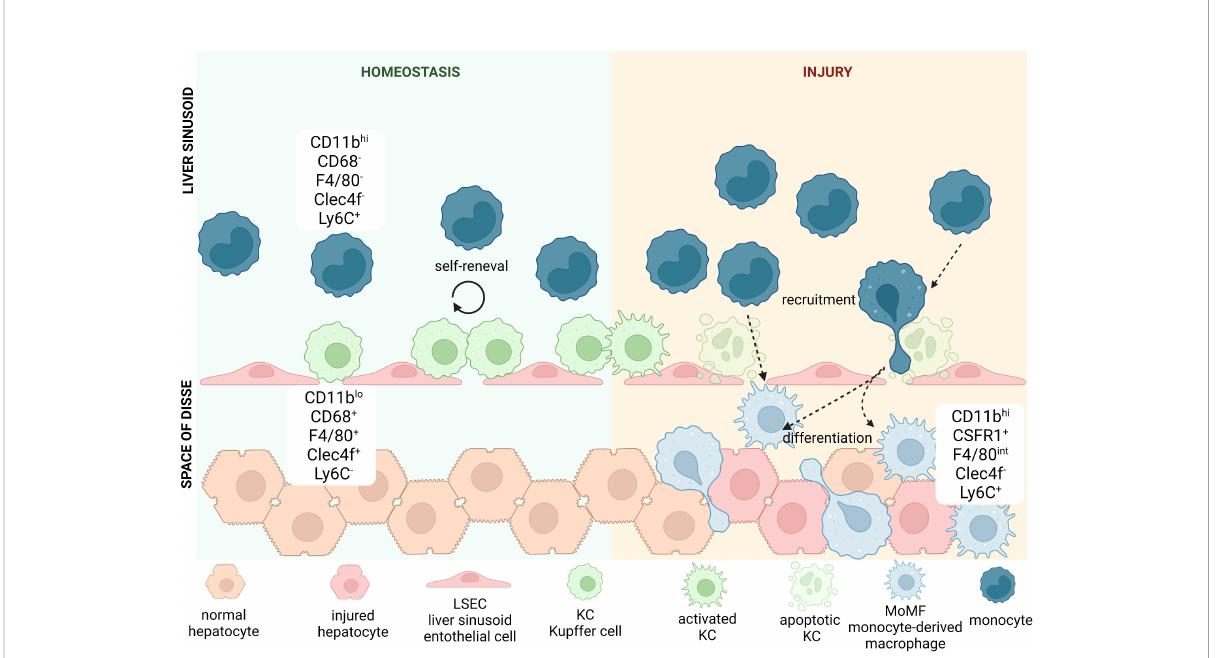
FIGURE 2 Heterogeneity of hepatic macrophages. In mice, liver-resident macrophages known as Kupffer cells (KCs) are classically de fi ned by positive expression of CD11b, CD68, F4/80, Clec4f and negativity for Ly6C. They are located in liver sinusoids, where they adhere to liver sinusoid endothelial cells (LSECs). KCs thanks to their particular location remain in close contact with blood stream, which allows them to detect a variety of antigens. During homeostasis the pool of KCs is being replenished by cell renewal. During acute or chronic liver injury KCs get activated and secrete cytokines and chemokines that can recruit other immune cells from the circulating blood. Some of the secreted cytokines or chemokines thanks to fenestrae present between LSECs can reach liver parenchyma and directly affect hepatocytes and other immune cells located there. Haptic injury and/or chronic in fl ammation increases apoptotic rate of KCs and when self-renewal does not suf fi ce to maintain their population, we can observe increased recruitment of monocytes, characterized by positivity for CD11b and Ly6C, with concomitant negativity to CD68, F4/80 and Clec4f. Once they enter parenchyma through endothelial fenestration, they differentiate into KC-like cells called monocyte-derived macrophages (MoMFs), that resemble the phenotype and function of KCs. These highly pro-in fl ammatory cells can be recognized by positivity for some markers typical for both KCs and monocytes: CD11b, F4/80 and Ly6C, while they remain negative for Clec4f. They also repopulate hepatic macrophages niche after increased death of KCs due to